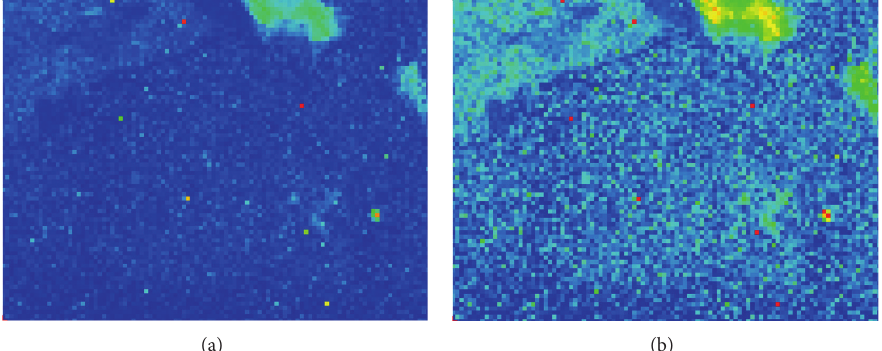
Figure 3: (a) Raman map with its original intensity range [0–420]. (b) Raman map with its reduced intensity range [0–210].